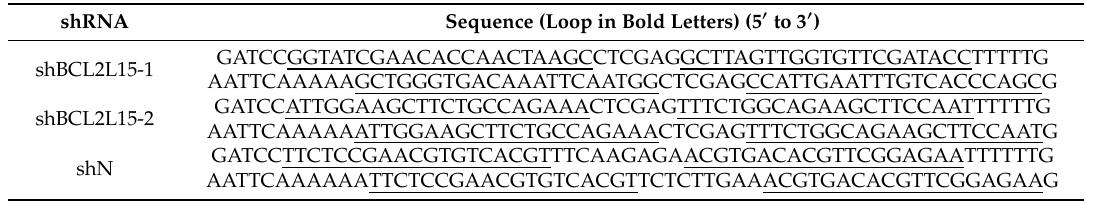
Table 1. Short hairpin interfering RNA (shRNA)